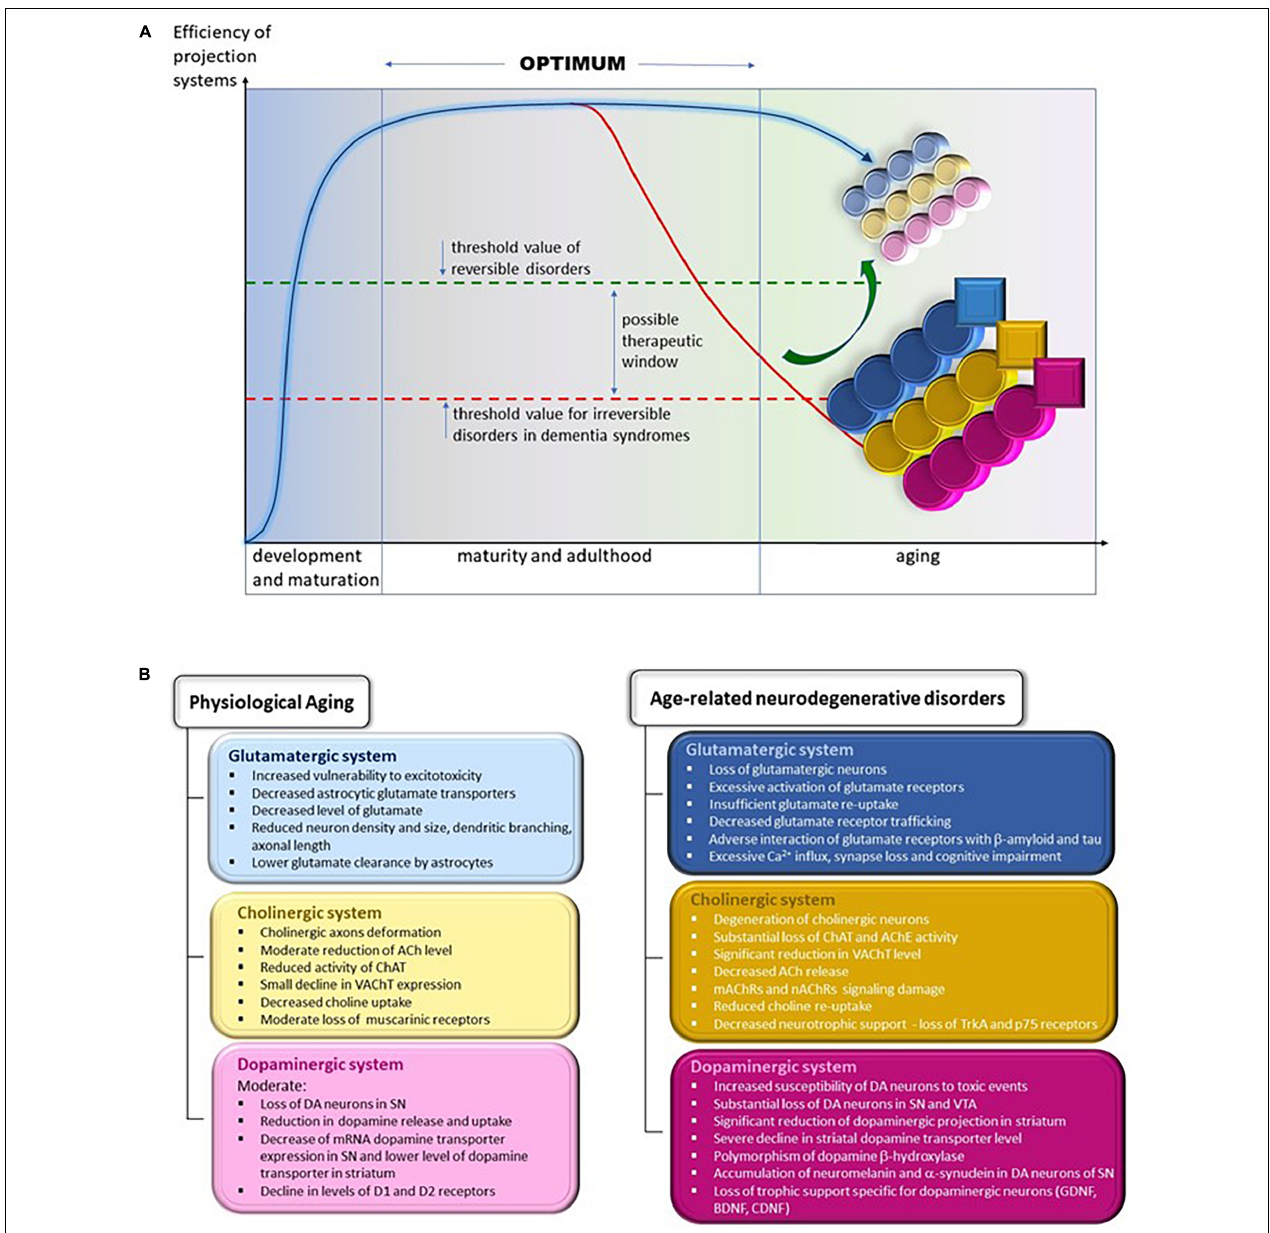
FIGURE 2 | (A) Changes in the efficiency of projection systems during physiological aging and in age-related neurodegenerative disorders. Efficiency of projecting systems declines slowly during physiological aging because of the slow but progressive deterioration in various mechanisms affecting cholinergic, glutamatergic, and dopaminergic systems, symbolized by small, lightly colored circles; yellow, cholinergic; blue, glutamatergic; and pink, dopaminergic. The overall efficiency of these systems allows the elderly to remain fully independent in daily activities and to continue professional activities (threshold value of reversible disorders). We may assume that the accelerated worsening of the various process leads to their severe and extensive impairment, symbolized by larger and heavy colored circles. In addition, pathological processes appear that are not observed during physiological aging, symbolized by squares. The overall efficiency of projecting systems declines gradually, diminishing the functional independence and hampering professional activities. The overt decline calls for medical intervention, which helps to alleviate symptoms and probably may slow the progression of deterioration. At present, there are no therapies that reverse (symbolized by the green arrow) or even stop the progression of neurodegeneration. Thus, inevitably, functional regression continues up to complete dependence, necessitating round-the clock care until death. This situation is symbolized by being below the threshold value for irreversible disorders in the line for dementia syndromes line. (B) Specific changes in the structure and function of glutamatergic, cholinergic, and dopaminergic projection systems during physiological aging (left panel) and in age-related neurodegenerative diseases (right panel). ACh, acetylcholine; AChE, acetylcholine esterase; BDNF, brain-derived neurotrophic factor; CDNF, cerebral dopamine neurotrophic factor; ChAT, choline acetyltransferase; D1 and D2, dopaminergic receptors 1 and 2; DA, dopamine/dopaminergic; GDNF, glial cell line-derived neurotrophic factor; mAChRs, muscarinic acetylcholine receptors; nAChRs, nicotinic acetylcholine receptors; p75, low-affinity nerve growth factor receptor; SN, substantia nigra; TrkA, tropomyosin receptor kinase A/high-affinity nerve growth factor receptor; VAChT, vesicular acetylcholine transporter; VTA, ventral tegmental area.